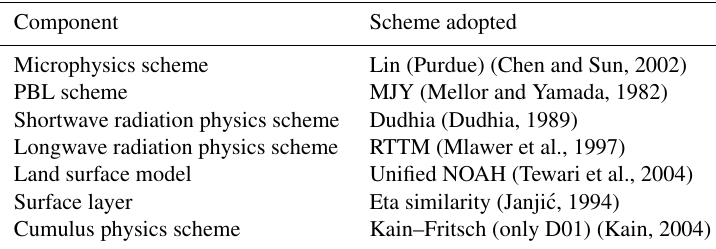
Figure 2. Panels (a) to (d) represent the respective daily rainfall (mm) amounts observed from 30 October to 2 November 2015; the points in these panels represent the weather stations, and the spatially distributed values represent the radar estimation. (e) Surface pressure and weather fronts at 00:00UTC on 1 November 2015 from http://www1.wetter3.de/, © Met Office. (f) Elevation maps of the Ancinale River catchment and (g) the Bonamico Creek catchment. Table 1. Main WRF physical options selected for the